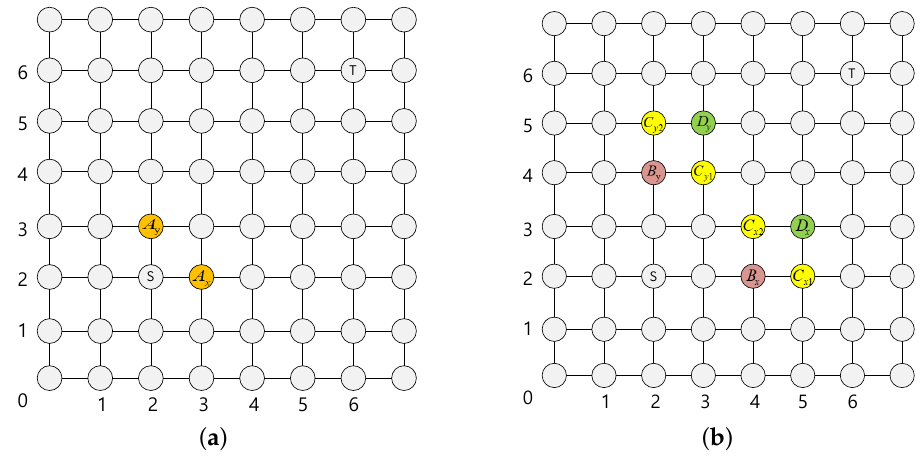
Figure 3. Two-stage routing for nodes in the central area. ( a ) Stage-1. ( b ) Stage-2.